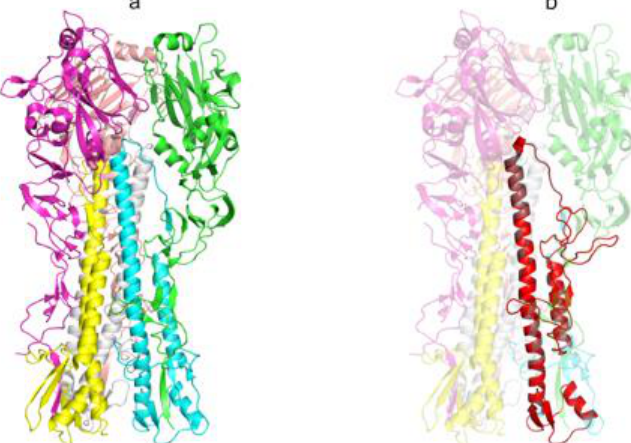
Figure 2. The spatial structure of influenza virus A / Puerto Rico / 8 / 1934(H1N1) HA protein and AgH1 antigen (extracellular portion). ( a ) The structure of the extracellular portion of influenza virus hemagglutinin protein trimer (PDB ID: 1RU7), elements of the secondary structure are shown with the ribbon diagram, individual chains have distinct colors and ( b ) the spatial structure model of artificial AgH1 antigen is shown with red color, the template HA structure is transparent. The picture was produced in PyMOL [45].